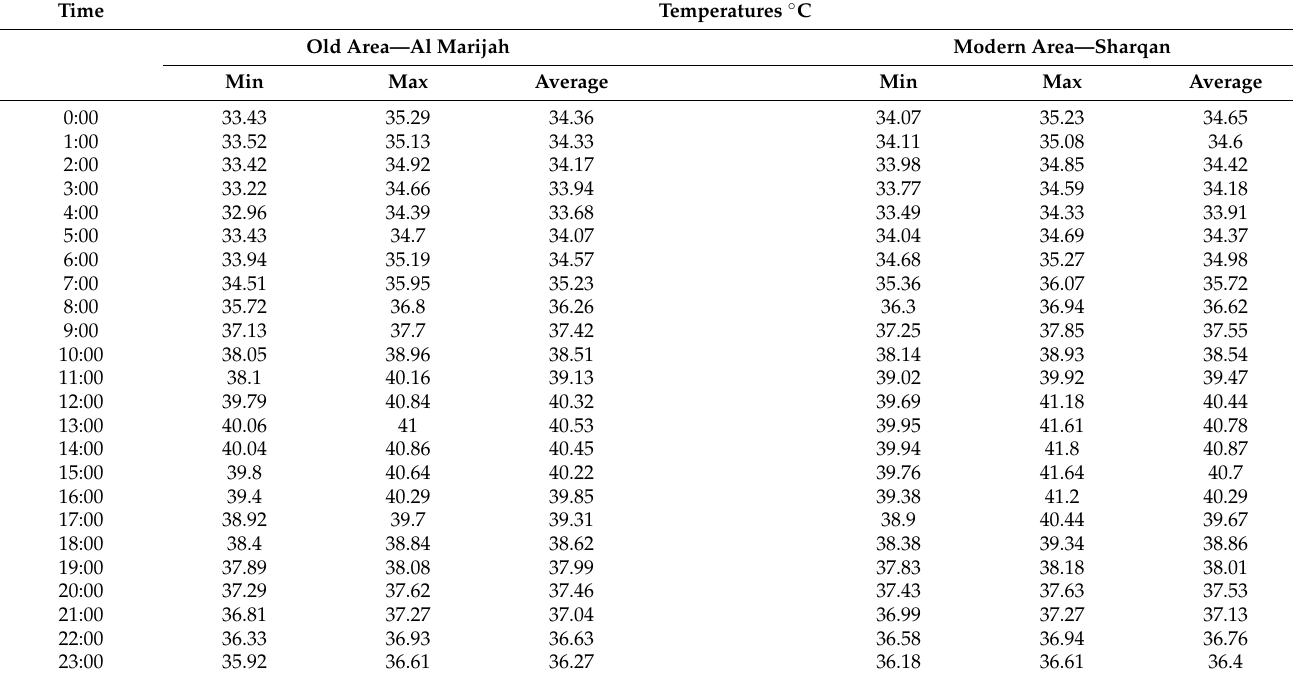
Table 3. Min, max, and average potential air temperatures for both cases old and new on 21st August.